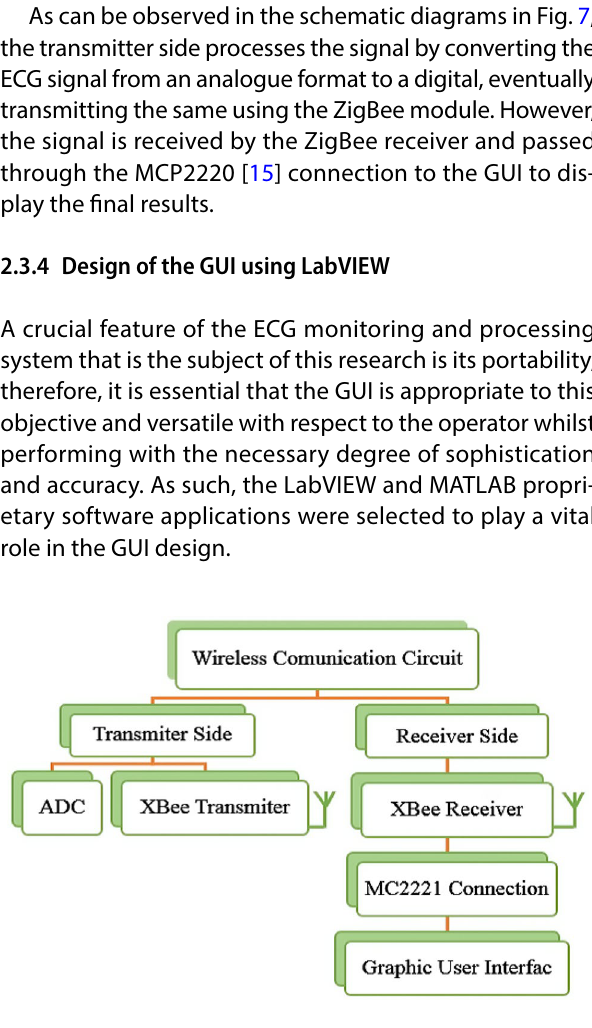
Table 1 Comparison of ZigBee RF module with other technologies